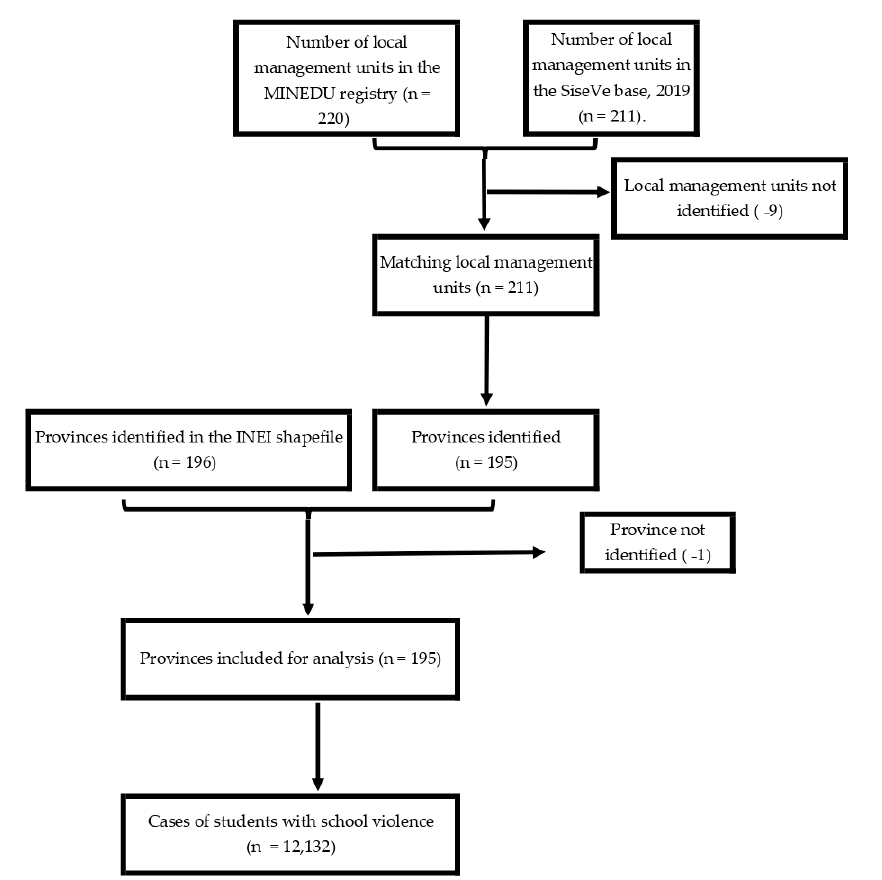
Figure 1. Development of the provincial cartographic base of school violence in the IEBR, 2019.